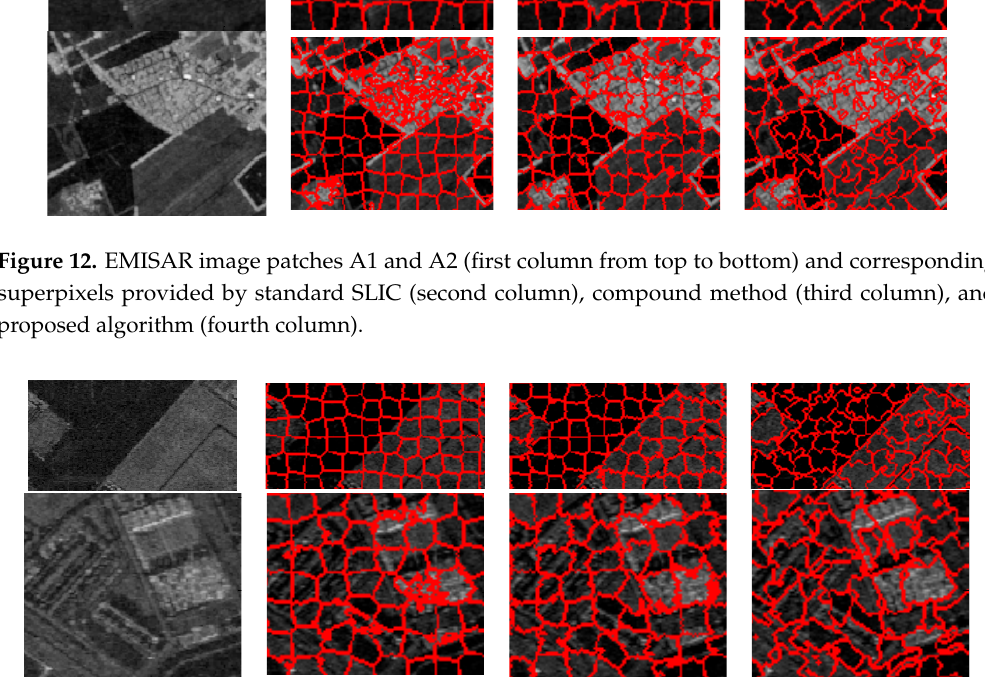
Figure 13. AIRSAR image patches B1 and B2 (first column from top to bottom) and corresponding superpixels provided by standard SLIC (second column), compound method (third column), and proposed algorithm (fourth column).